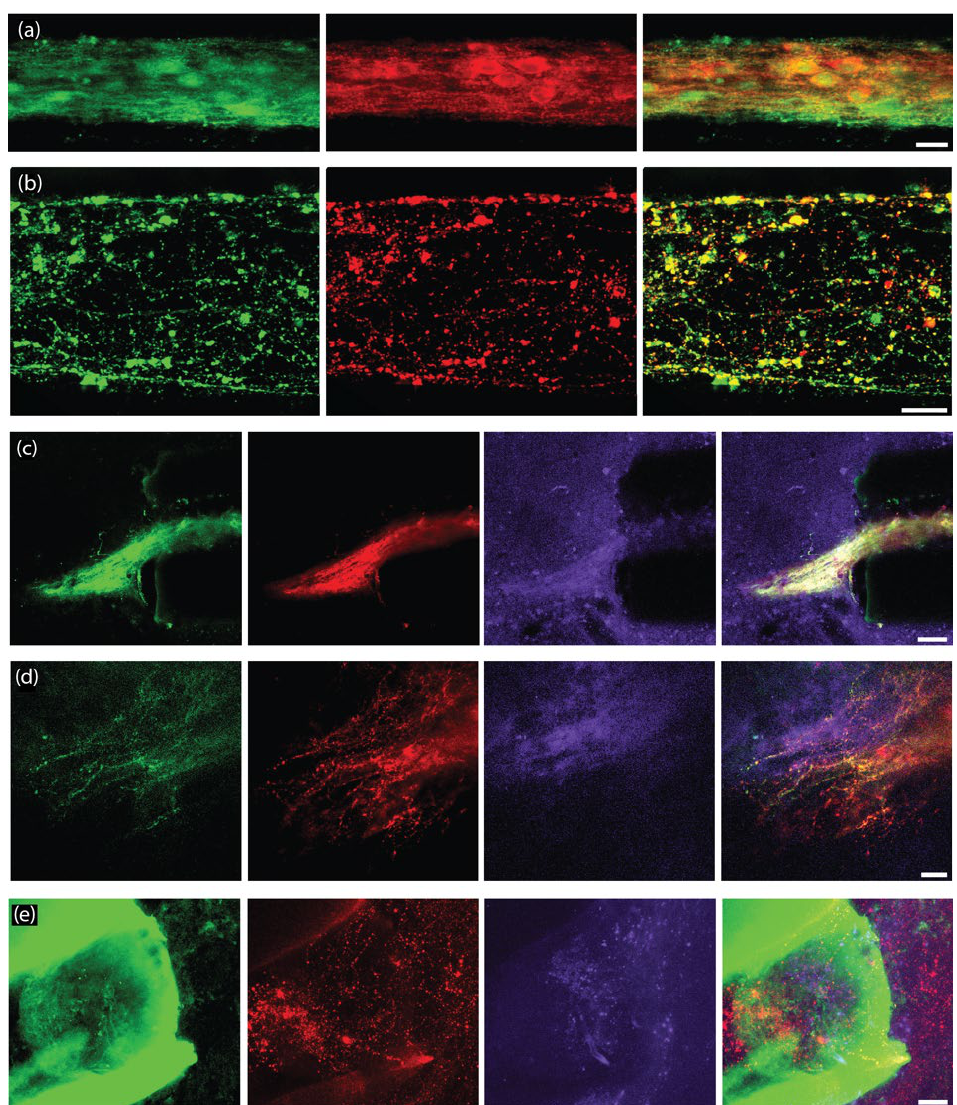
Figure 10. Survival and outgrowth of enriched TE-NSPs at 1-month post-implant in rat 6-OHDA lesion model of PD. Representative confocal reconstructions of implanted enriched TE-NSPs at 1- month post-implant labeled via immunohistochemistry to denote GFP (GFP, green), dopaminergic neurons/axons (TH, red), and synapses (synapsin, purple). ( a ) Dopaminergic neurons within the aggregate region displayed healthy morphologies. ( b ) Dopaminergic neurites maintained healthy projections longitudinally within the tube. ( c , d ) TE-NSP neurons exhibited neurite outgrowth into the host SNpc from the aggregate region. In these instances, regions containing outgrowth displayed concentrated synapsin labeling. ( e ) TE-NSPs also exhibited neurite outgrowth into the host striatum from the axonal region. In these instances, thin neurites were observed, projecting from areas of dense TH labeling within the end of the tube; note, in this example, the micro-column is autofluorescing green. Scale bar ( a , b ) = 25 µm. Scale bar ( c ) = 50 µm. Scale bar ( d , e ) = 25 µm.